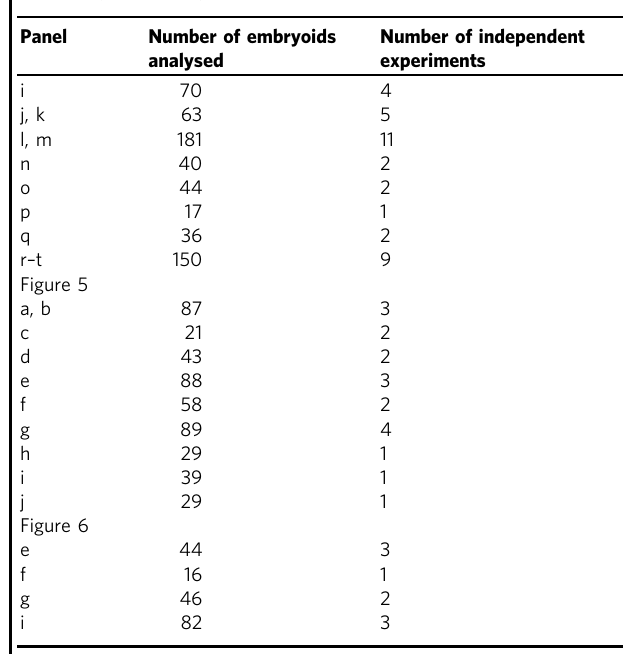
Supplementary Fig. 14 for data of Fig.